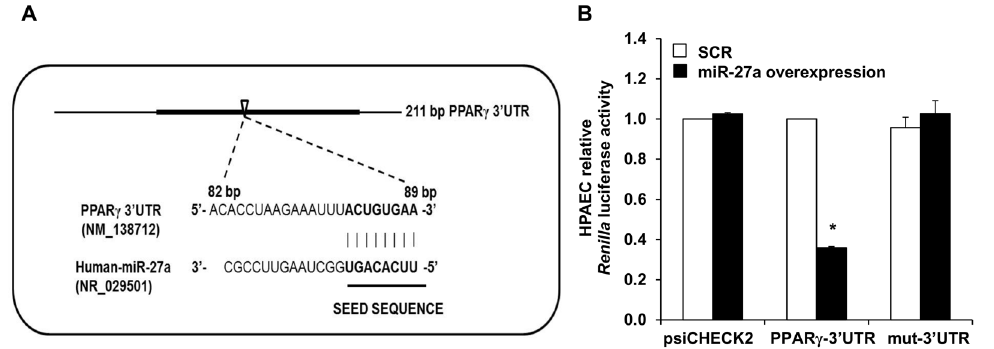
Figure 2. PPAR c is a target gene of miR-27a. A. Schematic illustration of the human PPAR c 3 9 UTR which contains a putative binding site (open arrowhead) for miR-27a. The miR-27a seed sequence is shown in bold font. B. HPAECs were incubated in a 24-well plate (1 6 10 4 cells/well) for 24 h, washed with PBS, and then fresh growth medium was added before transfection with PPAR c -3 9 UTR luciferase reporter constructs. Wild-type vector (psiCHECK2) or psiCHECK2-PPAR c construct, or mut-3 9 UTR construct with or without 30 nM of miR-27a mimic or scrambled miRNA (SCR) were transiently co-transfected into HPAECs. After 72 h, HPAEC lysates were harvested and analyzed for Renilla and firefly luciferase activities. Each bar represents Renilla luciferase activity in relative light units normalized to firefly luciferase activity and expressed relative to HPAECs treated with SCR constructs. n=3, * p , 0.05 vs. SCR-PPAR c -3 9 UTR constructs.